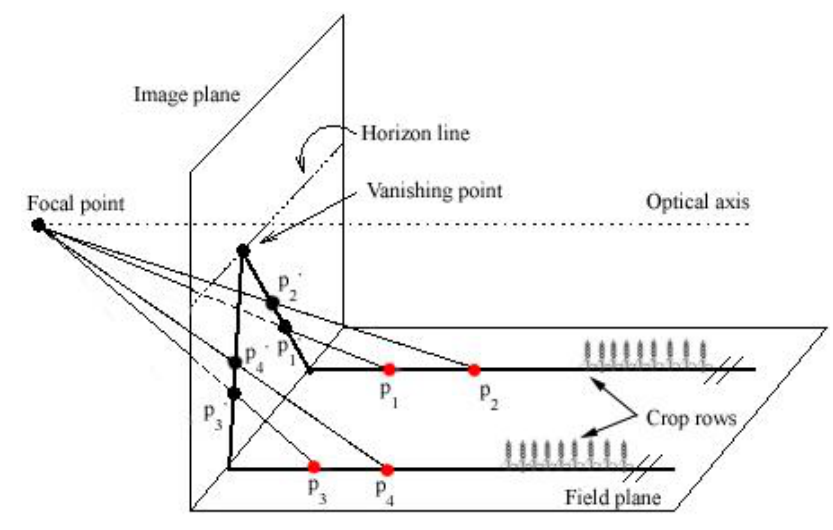
Figure 3. Geometry of the central projective model. Parallel crop rows in the field plane are not parallel and intersect at the vanishing point in the image